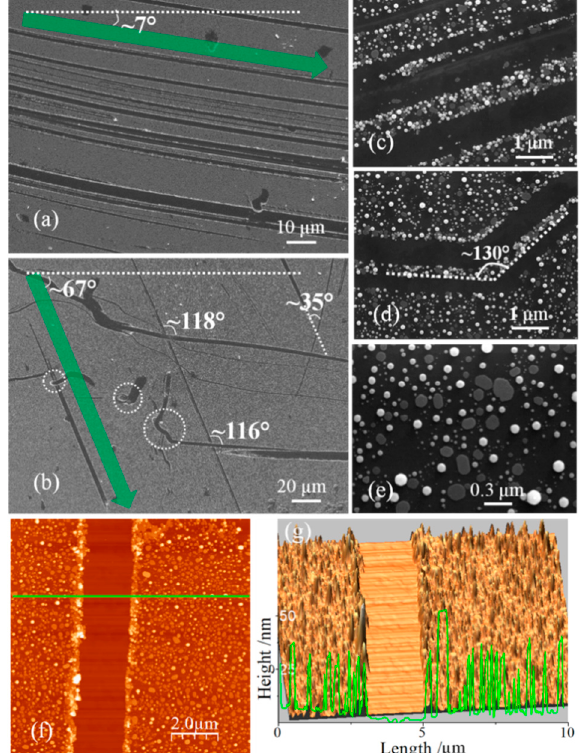
Figure 2. ( a , b ) Macro view of In trenches. ( c – e ) Magnified image showing more details about In trenches. ( f ) AFM image of one trench after the sliding of In particles. ( g ) Corresponding 3D image. The scale bars are marked in each image.